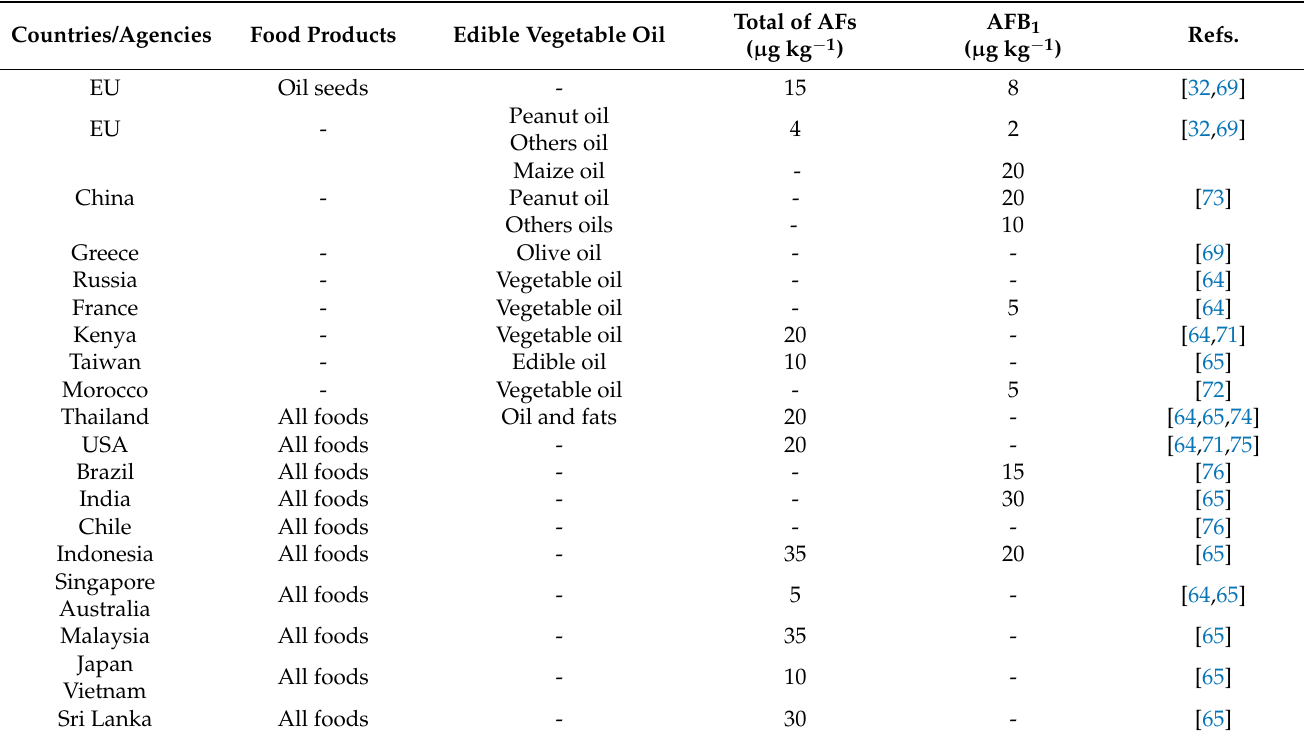
Table 1. The maximum limits ( µ g kg − 1 ) established for major AFB 1 in some countries/regions for edible